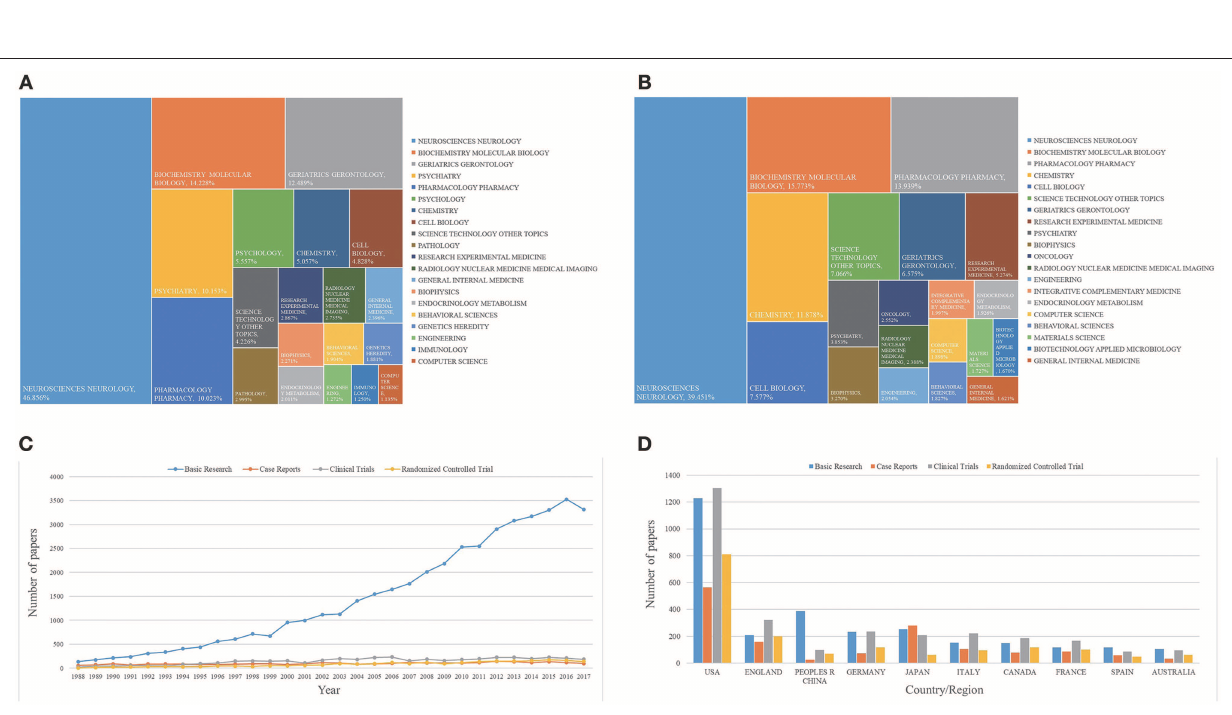
Frontiers in Human Neuroscience | www.frontiersin.org